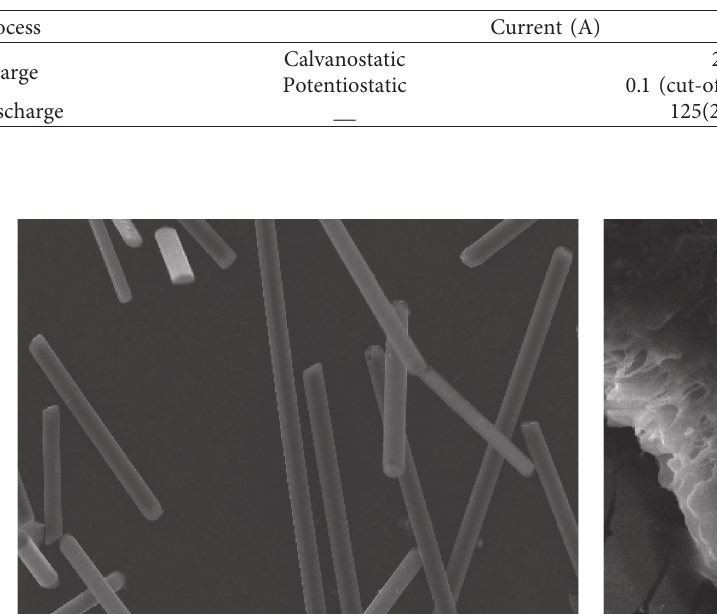
Figure 3: The experimental setup for evaluating the thermal response of the ternary lithium battery cooling module with the CPCM. Table 2: Charge/discharge